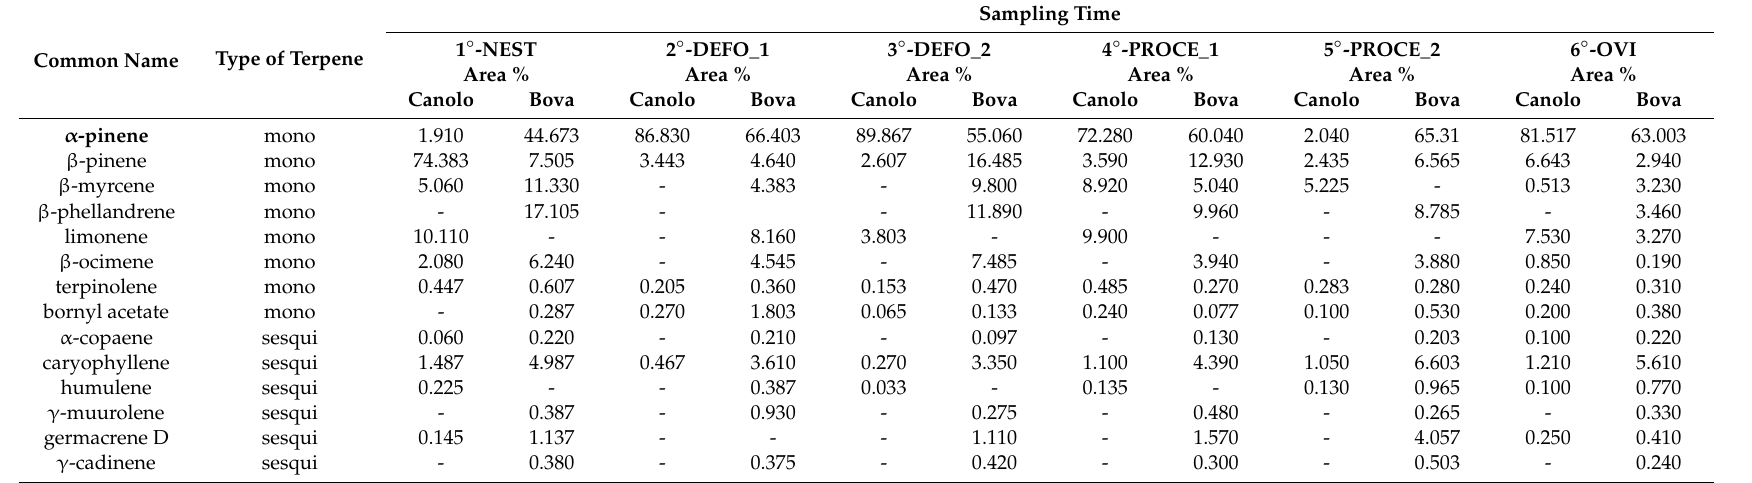
Table 3. Volatile organic compounds from the needles of pine processionary moth-infested Calabrian pines detected in at least two replicates out of three at each sampling time in the two sampling sites of Canolo and